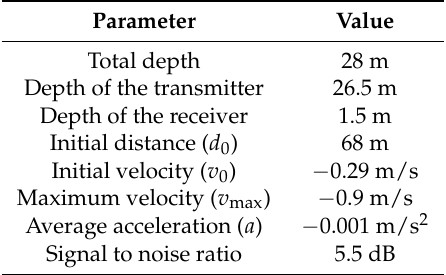
Table 1. Sea trial environmental